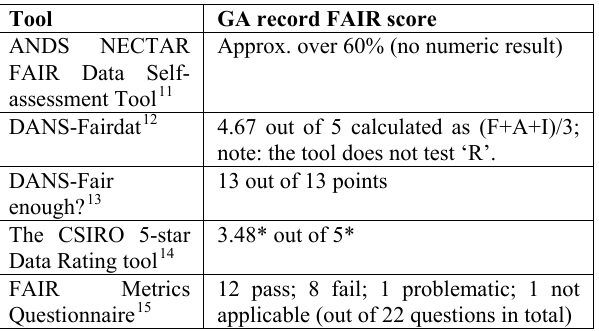
Table 2 FAIRness status of geodetic metadata record – tested example dataset: Geodesy – Continuously Operating 10